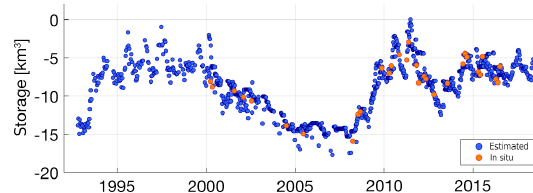
Figure 7. Time series of relative storage for Lake Sakakawea. Ob- served records are in orange; modeled records are in